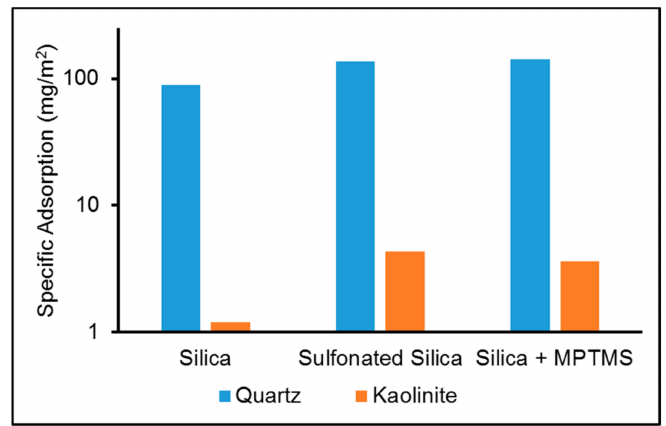
Figure 11. Specific adsorption of NP (mg/m 2 ) on quartz and